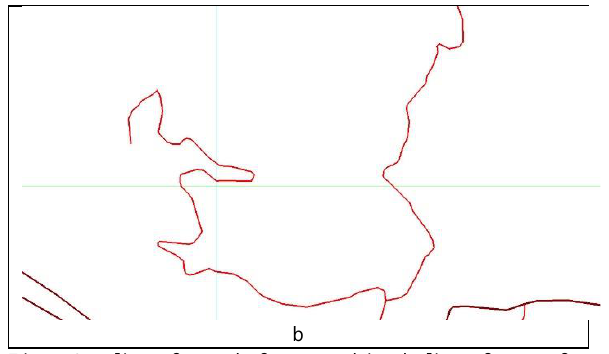
Figure 6. a: linear feature before smoothing. b: linear feature after smoothing